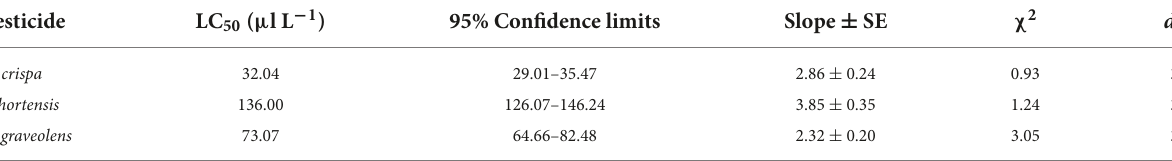
TABLE 2 Median lethal concentration (LC 50 ) estimated using probit analysis for adult female Tetranychus urticae exposed to N. crispa , S. hortensis , and A. graveolens oils for 24 h. Pesticide